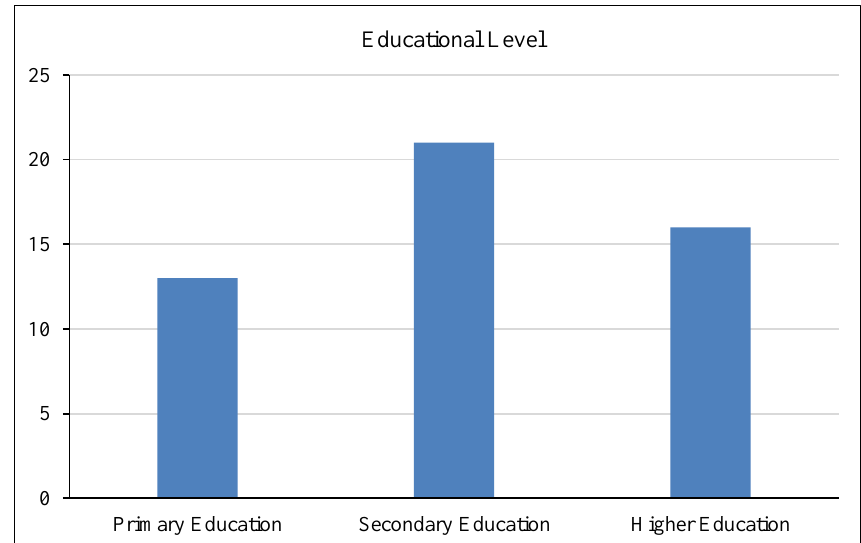
Figure 5. The educational level of the participants